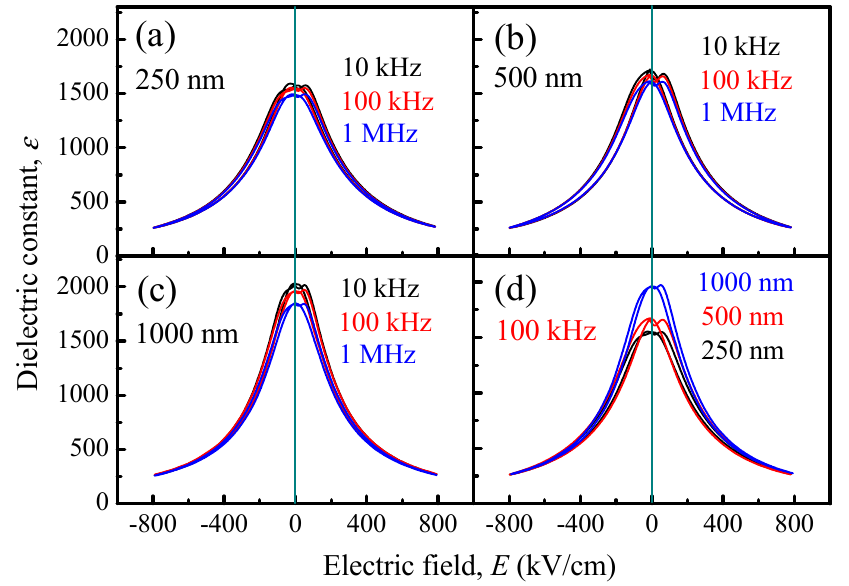
Figure 2. Dielectric constant–electric field ( ε - E ) curves of ( a ) 250-nm, ( b ) 500-nm and ( c ) 1000-nm PLZT films, as a function of frequency. ( d ) Comparison of ε - E curves of PLZT films measured at 100 kHz. The measurements were performed at 800 kV/cm.